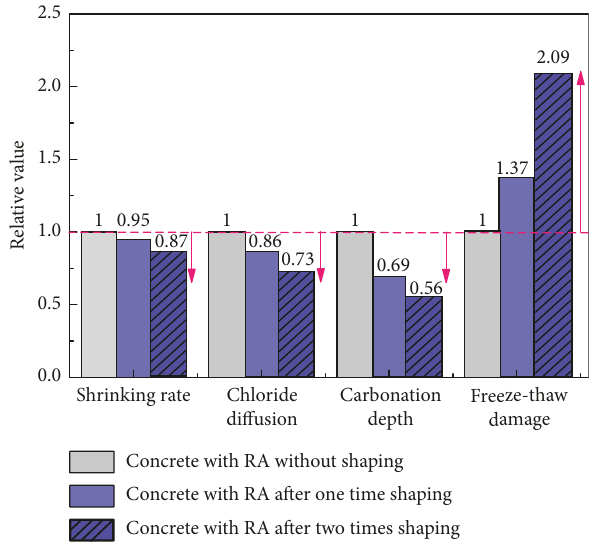
Figure 13: Durability properties of concrete with RA after particle shaping